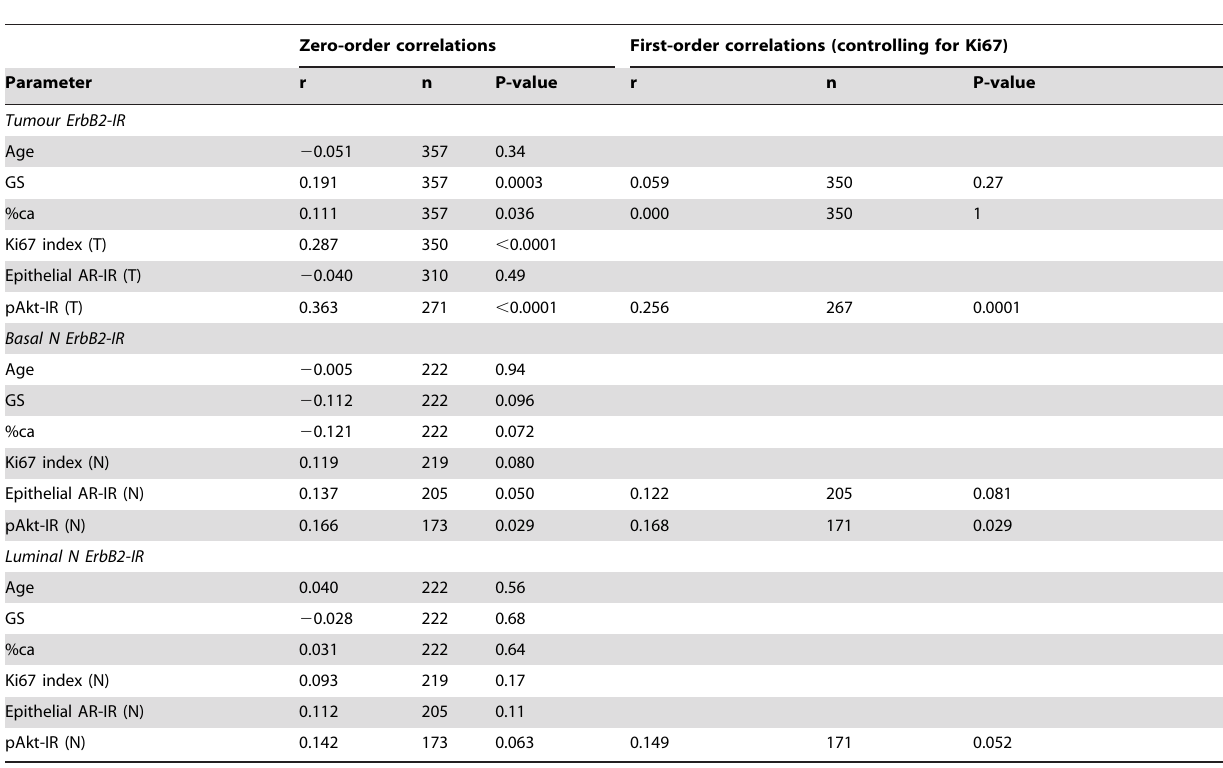
Table 1. Correlations of Pca tissue microarray ErbB2-IR scores with clinical and biochemical measures.